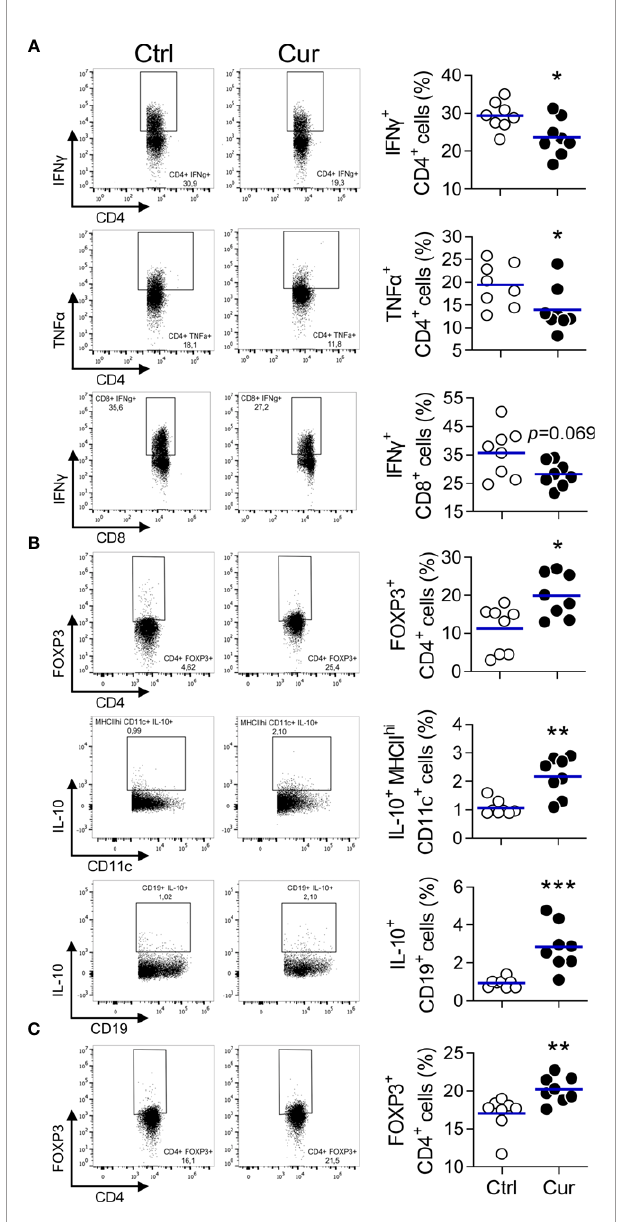
FIGURE 3 | Curcumin-induced atheroprotection associates with attenuated Th1 and increased regulatory response. (A, B) Spleen cell suspensions from curcumin- or vehicle-treated mice from Figure 1 were stained with appropriate mAbs to determine the frequency of (A) IFN g + CD4 + , TNF a + CD4 + , and IFN g + CD8 + cells, as well as (B) FOXP3 + CD4 + , IL-10 + MHCII hi CD11c + DC and IL-10 + CD19 + B cells by fl ow cytometry. (C) Popliteal lymph node (pLN) cell suspensions were also obtained and the frequency of the FOXP3 + CD4 + cell population quanti fi ed. Left panel shows representative dotplots. Each dot in the right panel represents an individual animal, and the line represents the mean from 8 mice/group. *P < 0.05; **P < 0.01; ***P < 0.001 (Mann-Whitney U